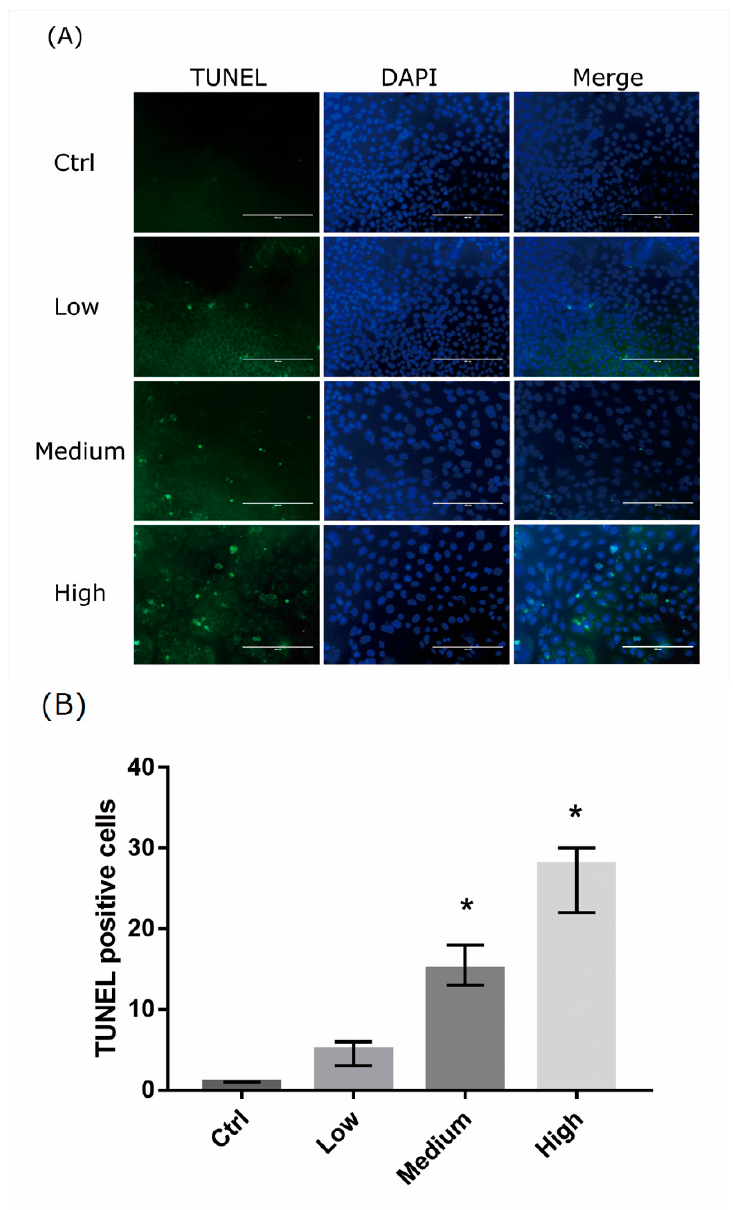
Figure 3. Apoptotic cells detected by terminal deoxynucleotidyl transferase-mediated dUTP-biotinide end labeling (TUNEL) in 661W cells. ( A ) Representative images of 661W cell apoptosis in controls and cells exposed to liquid crystal display (LCD) with low, medium, and high ocular energy exposure index for 24 h. Ctrl: control group, no light exposure; bar = 200 µ m. ( B ) Number of TUNEL-positive cells was counted in at least four randomly chosen views, represented as columns. Ctrl: control group, no light exposure; All data represent the median and the interquartile range. *p < 0.05 compared to the control group using the Kurskal-Wallis test with post hoc Dunn test; n = 3 in each group.